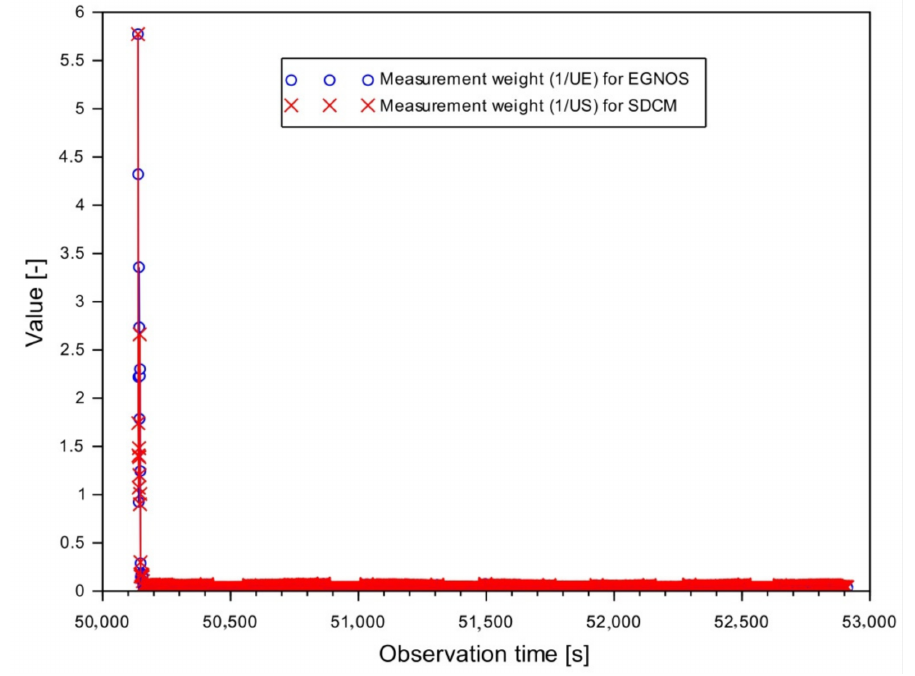
Figure 6. The measurement weights as a function of the inverse of total velocity (see Algorithms (6) and (7)). Table 2. The residuals along the B axis.